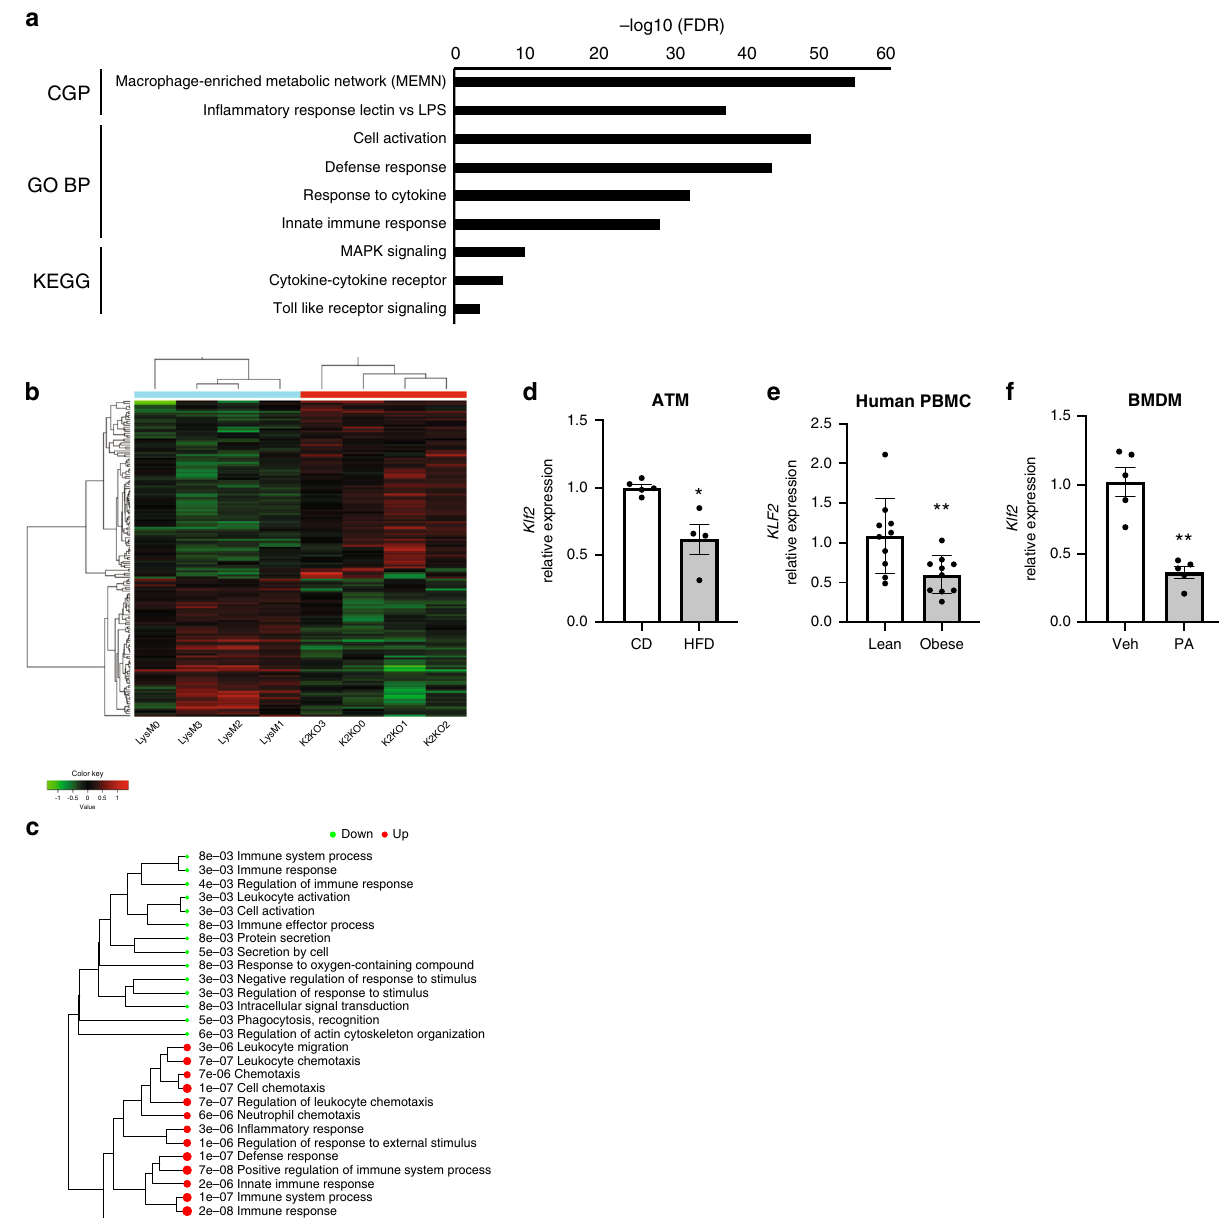
Fig. 1 Myeloid KLF2 regulates a macrophage-enriched metabolic network and is responsive to meta fl ammatory stress. a Gene-set enrichment analysis of bone marrow-derived macrophages (BMDMs) from myeloid KLF2 knockout or control mice demonstrating signi fi cant enrichment in the macrophage- enriched metabolic syndrome network (MEMN) in addition to several innate immune pathways. Several annotated genesets from the Molecular Signature Database were explored including CGP chemical genetic perturbations, GO BP Gene Ontology biological processes, and KEGG Kyoto Encyclopedia of Genes and Genomes n = 4 biological replicates. b Heatmap of hierarchal clustering of MEMN genes demonstrating genotype clustering, based on DEGs from n = 4 biological replicates. c Gene ontology analysis demonstrating up and downregulated genesets for MEMN differentially expressed genes, based on DEGs from n = 4 biological replicates. d Klf2 expression from adipose tissue macrophages (ATM) harvested from WT mice fed either control diet (CD, n = 5) or high-fat diet (HFD, n = 4) for one month, n represent biologically independent mice, p = 0.0159. e KLF2 expression in human peripheral blood mononuclear cells (PBMC) from lean and obese patients, n = 10 biologically independent human subjects, p = 0.0068 f WT BMDM Klf2 expression after acute treatment with palmitic acid (PA), n = 5 biologically independent mice, p = 0.0079. * p < 0.05, ** p < 0.01 by unpaired, two-tailed Student ’ s t -test, comparisons marked or indicated in fi gure legend. Error bars represent SEM. Source data are provided as a Source Data fi (Fig. 2e). Taken together, these data suggest that loss of myeloid KLF2 promotes a leptin-resistant phenotype, likely contributing to obesity in the basal and diet-induced states.